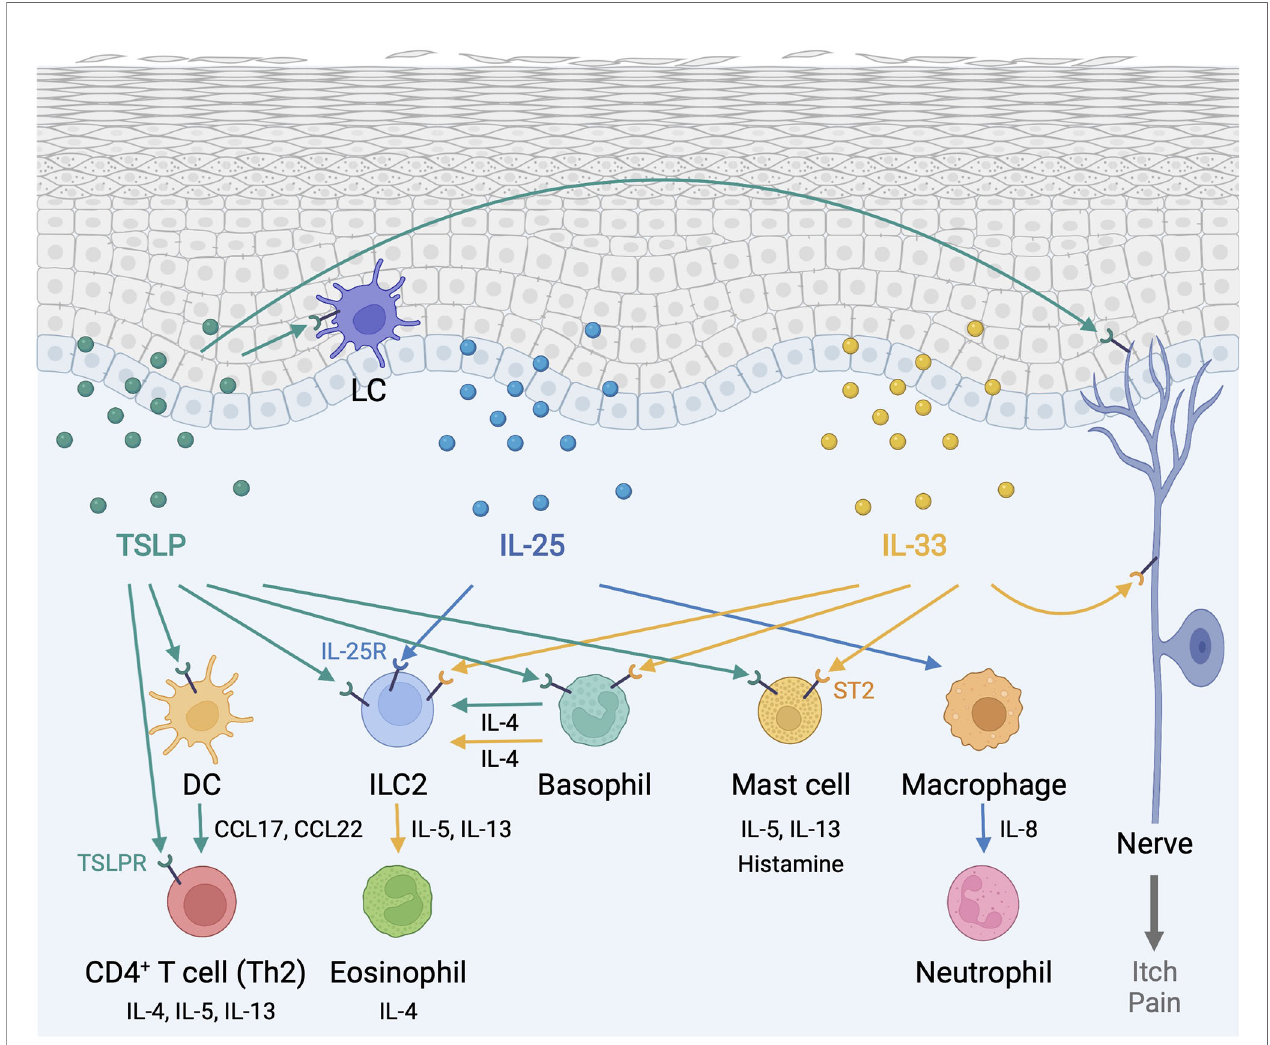
FIGURE 1 | Type 2 alarmin cytokines orchestrate immune responses in the skin. Epidermis-derived TSLP, IL-25, and IL-33 act as alarmins to instigate cutaneous type 2 immunity through a complex and pleiotropic network of innate and adaptive immune cells. In addition, TSLP and IL-33 provoke sensory neurons to mediate itch and pain responses. DC, dendritic cell; ILC2, group2 innate lymphoid cell; LC, Langerhans cell; TSLP, thymic stromal lymphopoietin; TSLPR, thymic stromal lymphopoietin receptor. Created with